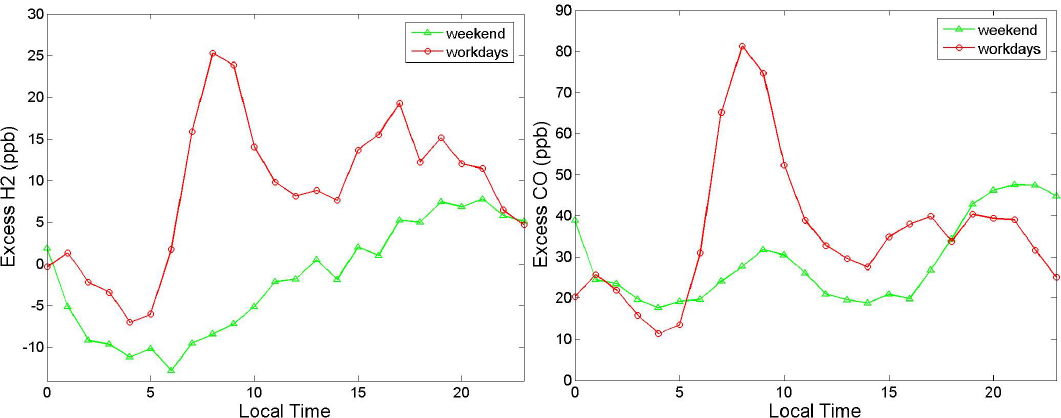
Fig. 7. Diurnal variation of excess hydrogen (a) and carbon monoxide (b) mixing ratios during workdays and weekends in September– October